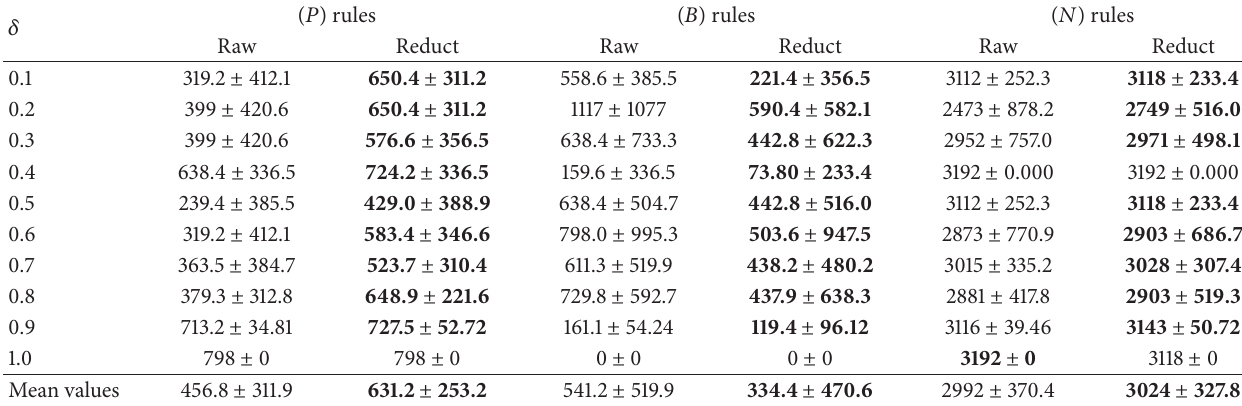
Table 2: The decision rules between raw data and decision-monotonicity criterion based reducts (Annealing).